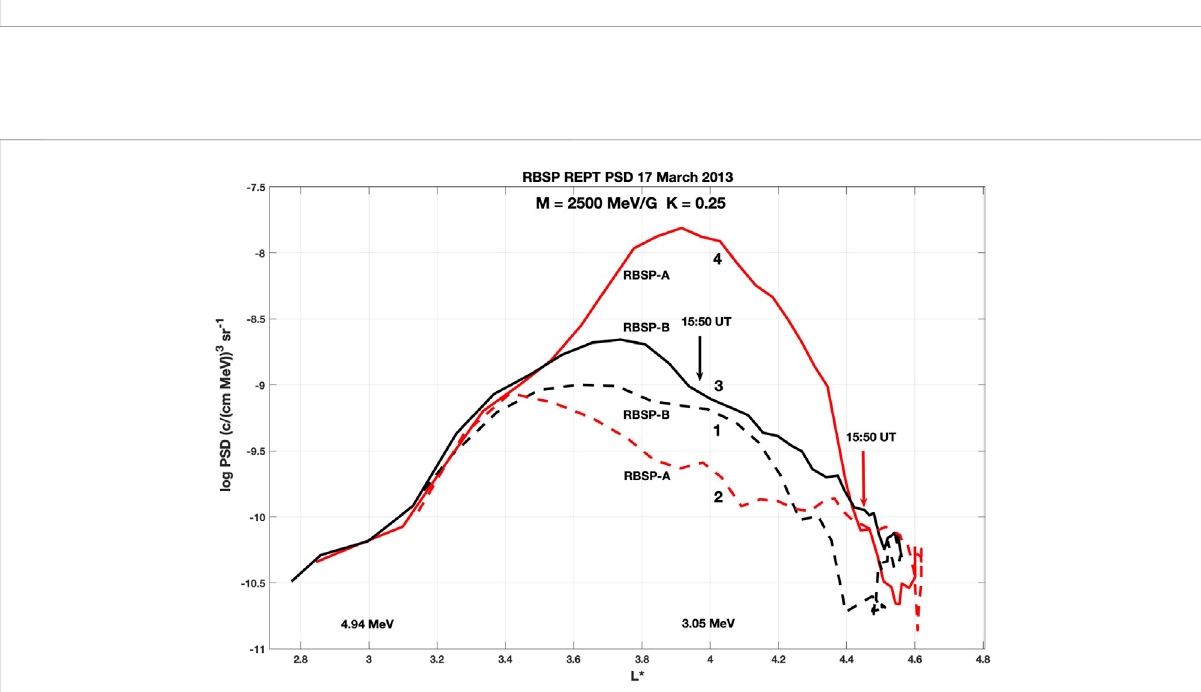
FIGURE 3 Van Allen Probes A and B power spectral density (PSD) vs. L plots showing the onset of the rapid recovery at 15:50 UT seen in Figure 1A. Curve numbers indicate the order in which the spacecraft crossed L* = 4 as RBSP-B preceded RBSP-A by ~ 1 h along successive outbound (dashed curves 1 and 2) and inbound (solid curves 3 and 4) orbits. A 10x increase in 2,500 MeV/G PSD observed by RBSP-A was associated with the injections and development of strong VLF